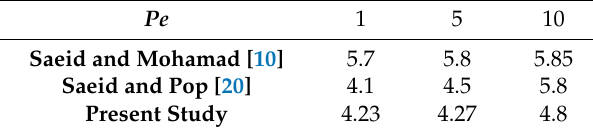
Table 1. The comparison of average Nu number for Ra = 100 [3]. Table 1 The comparison of average Nu number for Ra = 100 [3]